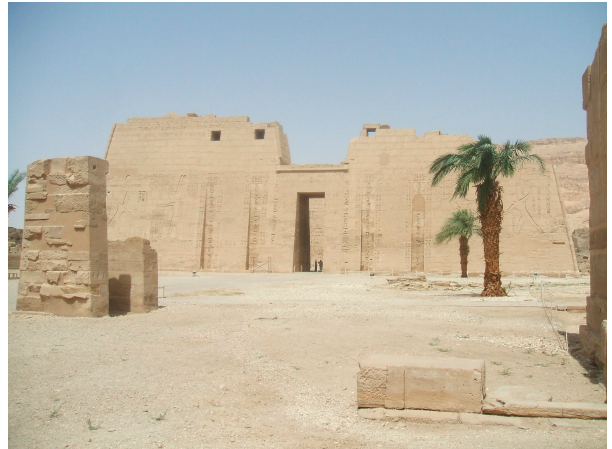
Figure 4. The main façade of Medinet Habu west Luxor.